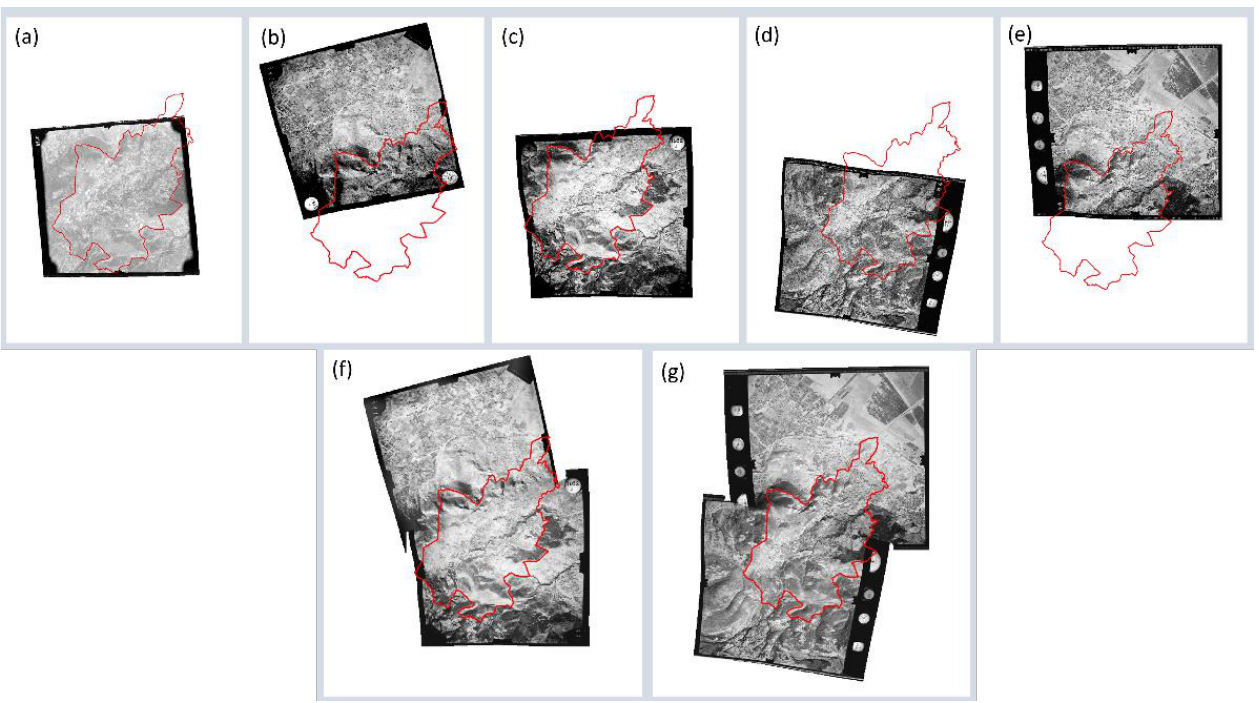
Figure 5. ( a ) 1945, ( b , c ) 1952, and ( d , e ) 1965 aerial photographs covering a portion of Ruen village, and mosaicked Ruen aerial photo of ( f ) 1952 and ( g ) 1965 (red vector shows the boundaries of the Ruen village).